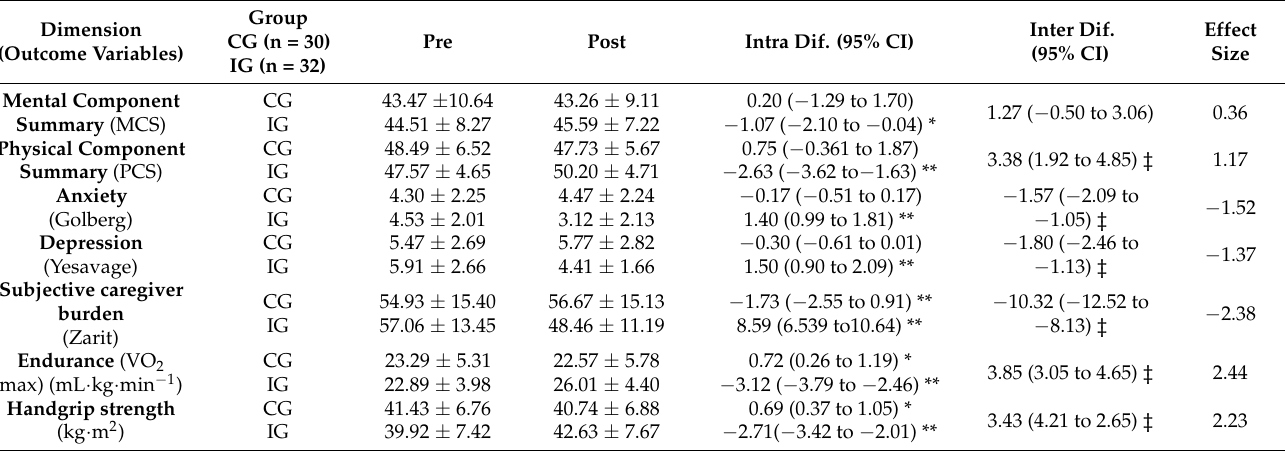
Table 6. Results (mean ± standard deviation) of the effect of the intervention on quality of life, psychological wellbeing, and physical